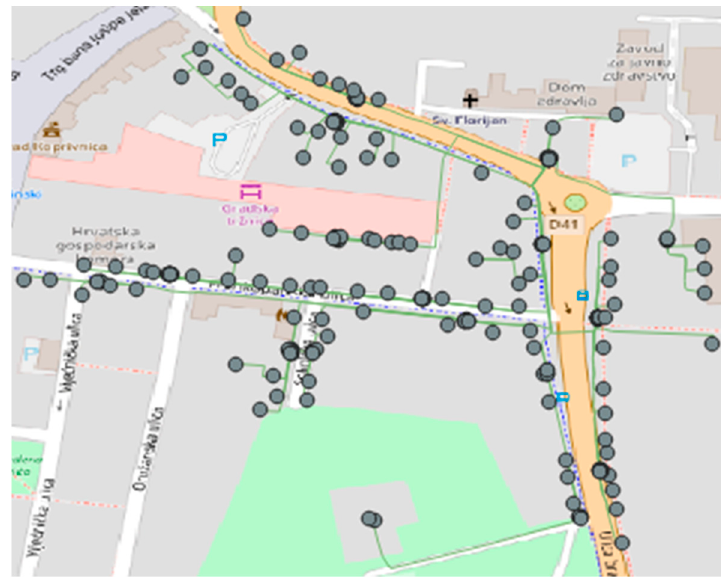
Figure 1. Modelled LV distribution network .